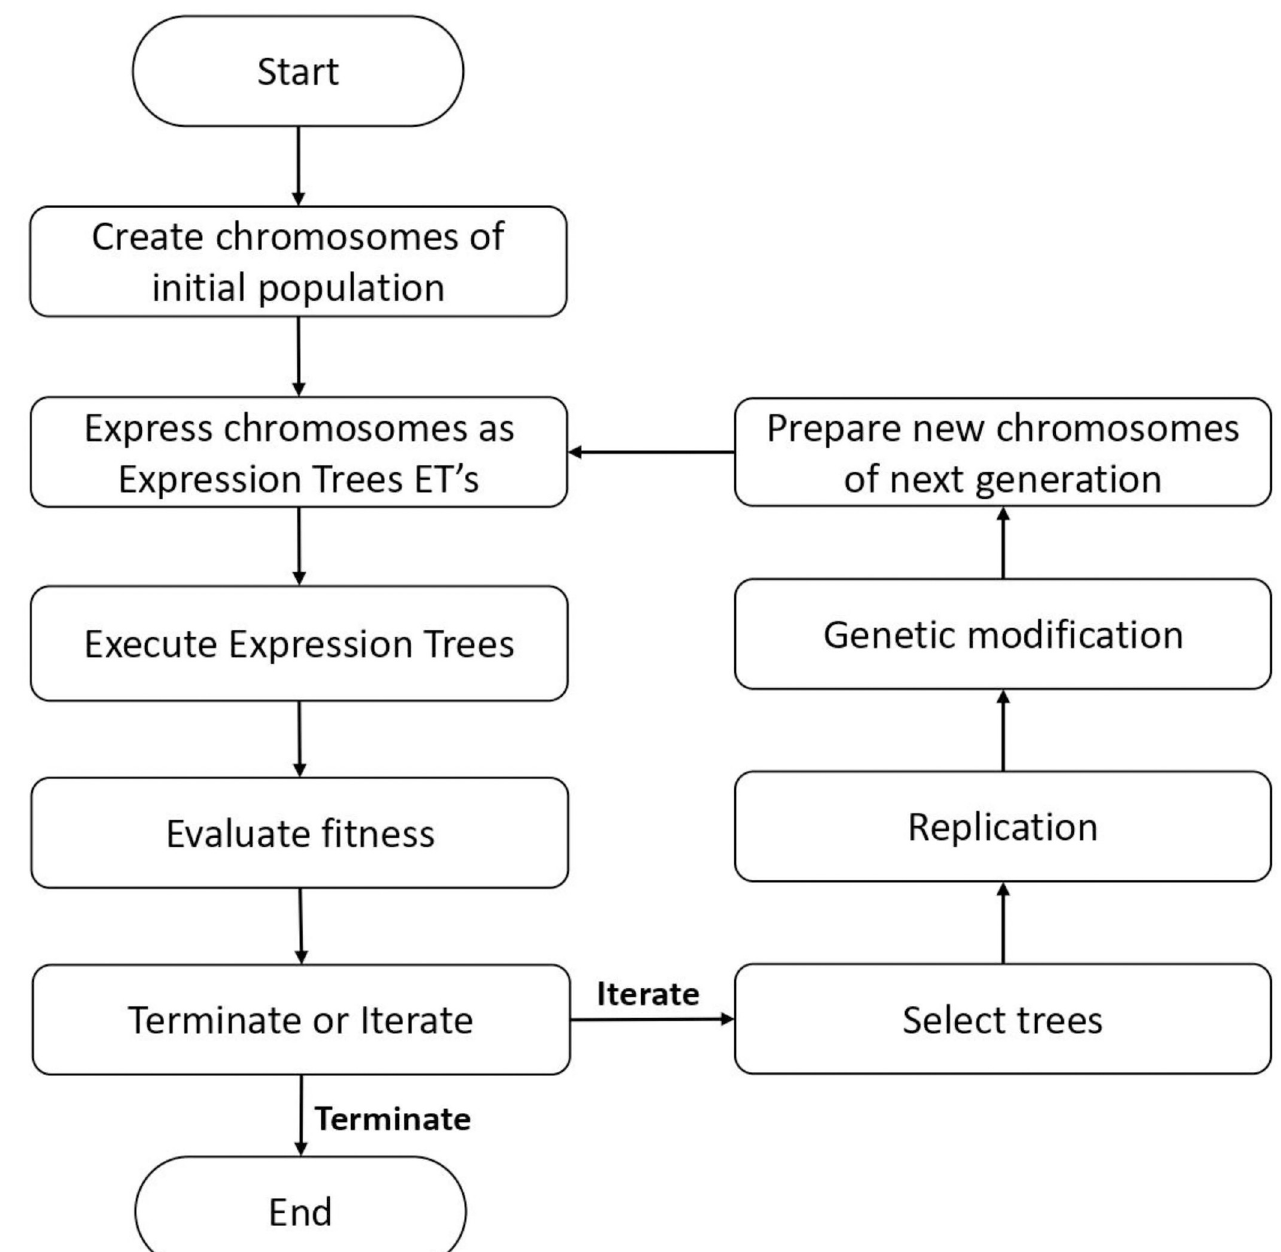
Fig 3. Steps involved in developing algorithm of